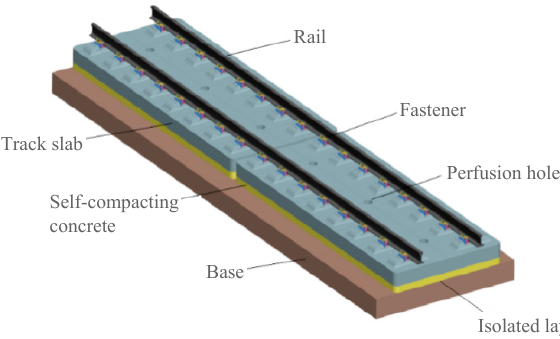
Figure 2. Schematic composite diagram of CRTS Ⅲ SBT.